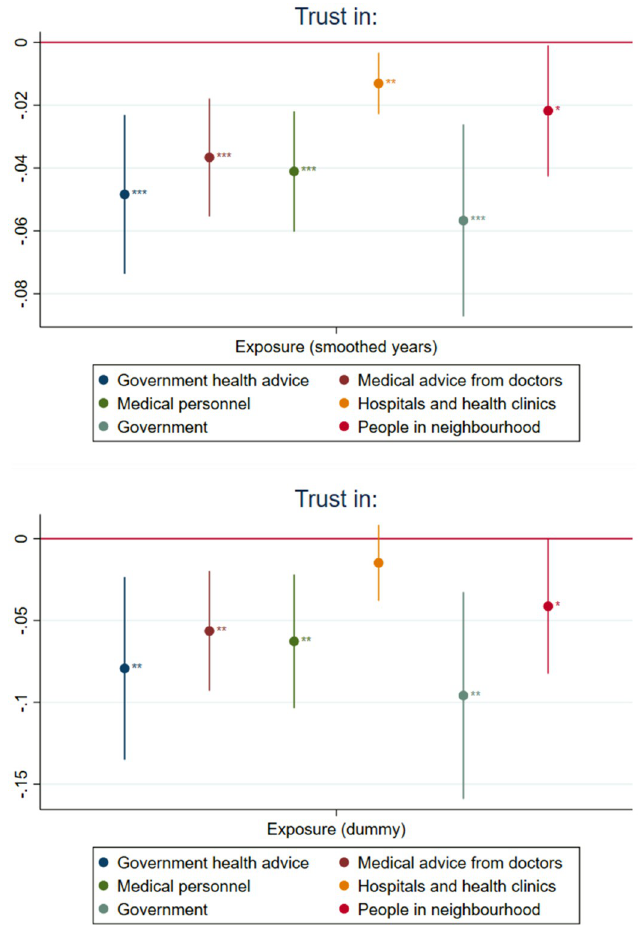
Fig 4. Effects of the exposure to Soviet communism on generalized trust and trust in medical care. Notes : The treatment variable is the length of exposure to Soviet communism in years smoothed with inverse hyperbolic sine function. Control variables: age fixed-effects, gender, country fixed-effects and country-specific time trend. Presented confidence intervals at 95% significance level are obtained using standard errors clustered by country. Statistical significance: � − p < 0.10, �� − p < 0.05, ��� − p < 0.01. Source : WGM